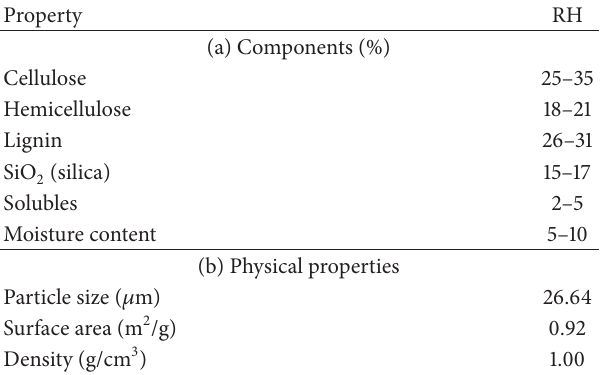
Table 1: (a) Components and (b) physical properties of RH [21]. Table 2: (a) Chemical and (b) physical properties of typical RHA fillers